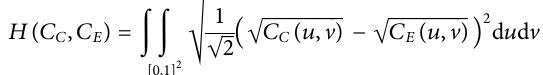
TABLE 1 | Experts ’ weights from dependence calibration score.